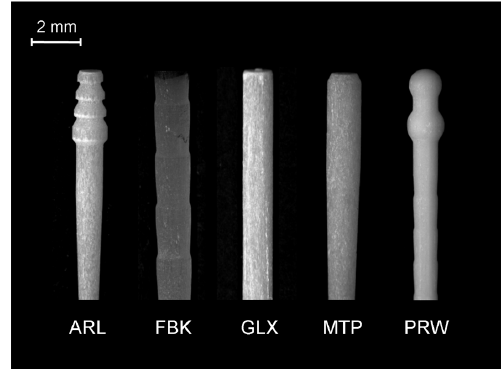
Figure 1. Stereomicroscopic image of the coronal and middle body parts of the posts used in the study (10×, bar = 2 mm).